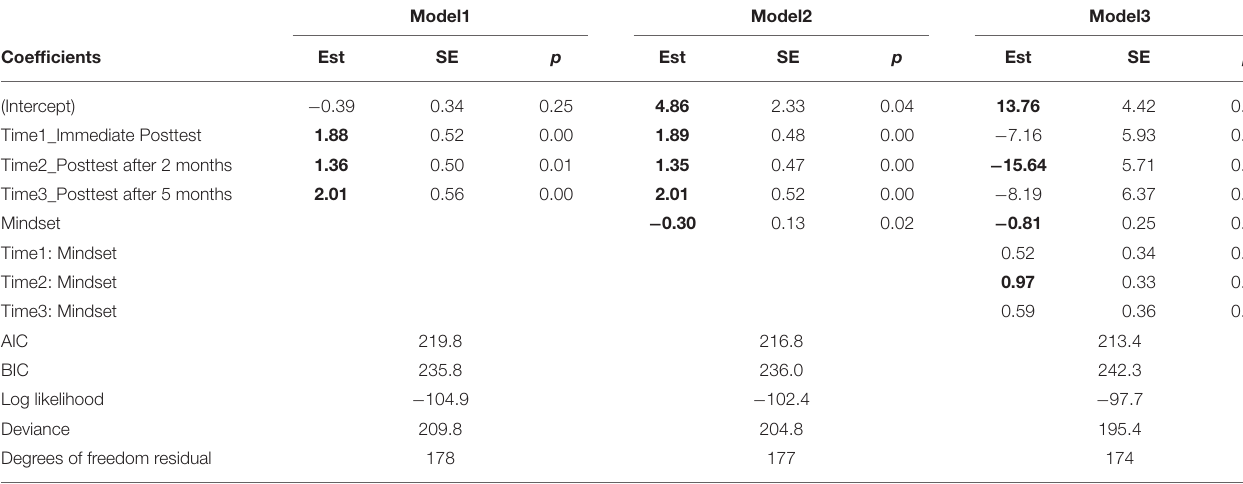
TABLE 4 | Summary of the three GLMM